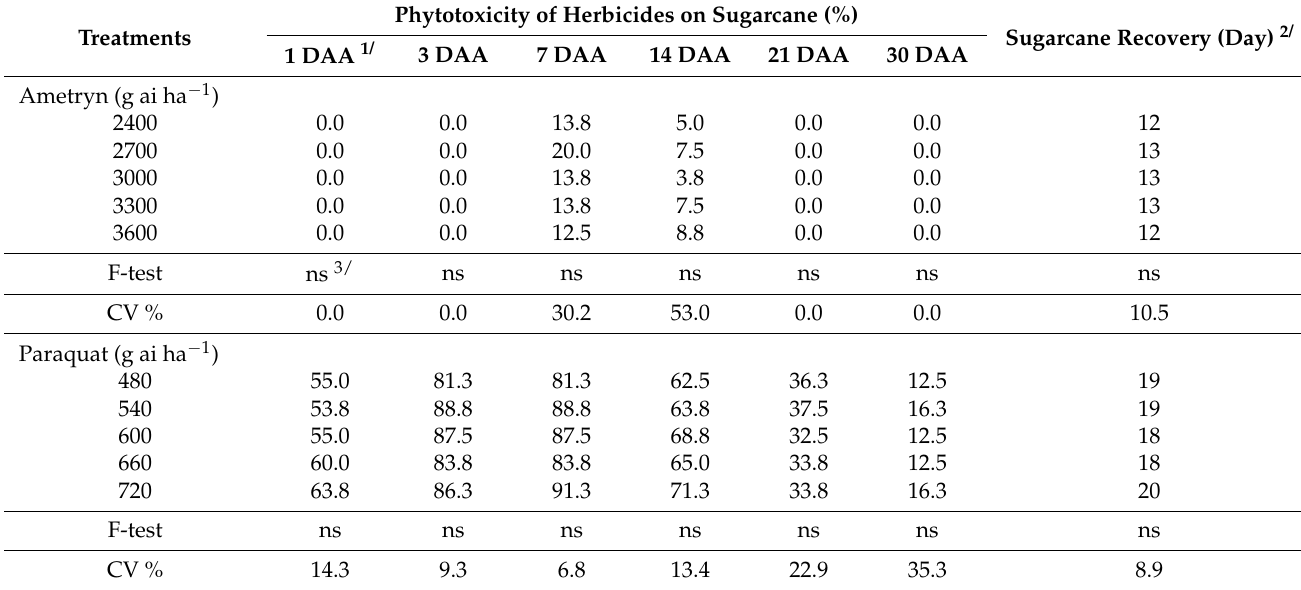
Sugarcane Recovery (Day) 2/